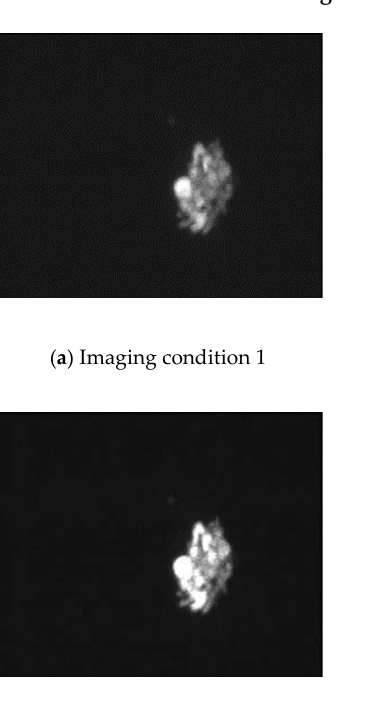
Figure 4. Target image.